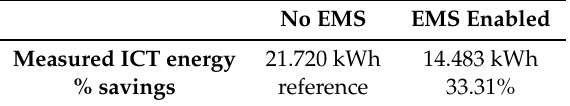
Table 3. Cloud computing data center’s federated site energy saving